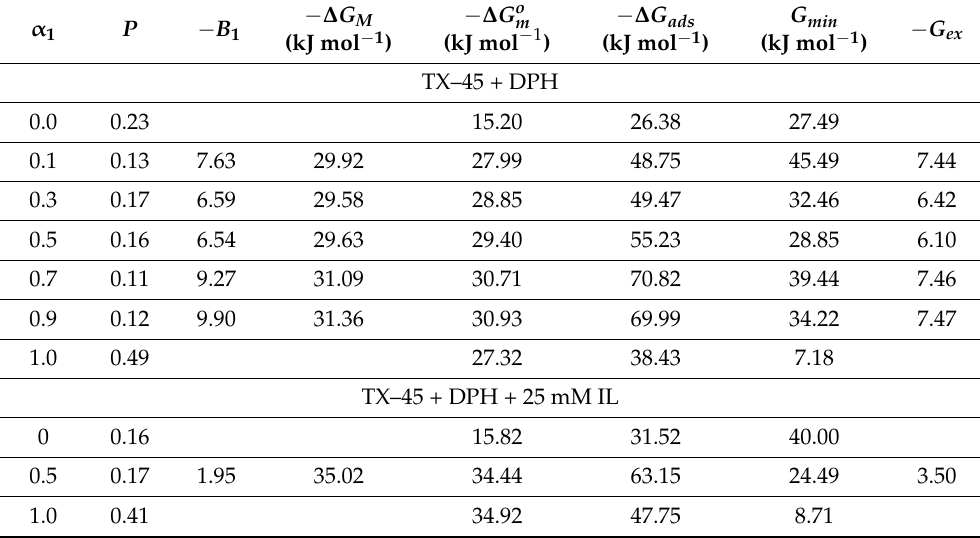
Table 3. Packing and energetic constraints of TX–45 & DPH mixtures in the attendance and non- attendance of 25 mM IL at T = 298.15 K